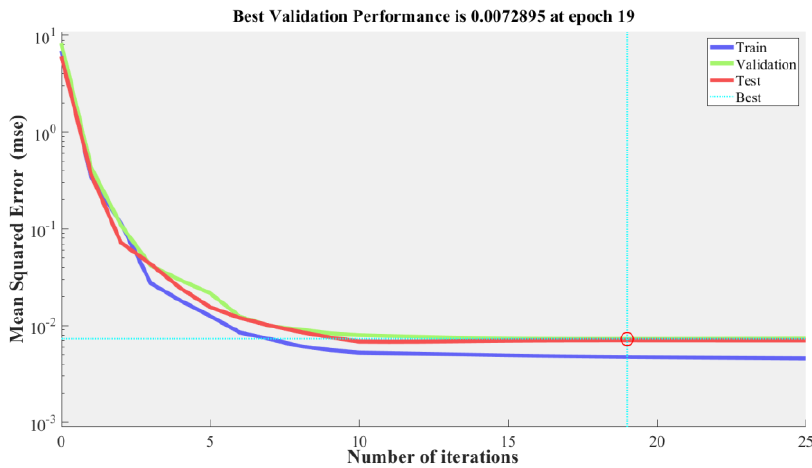
Figure 8. The MSE change curve of the model.